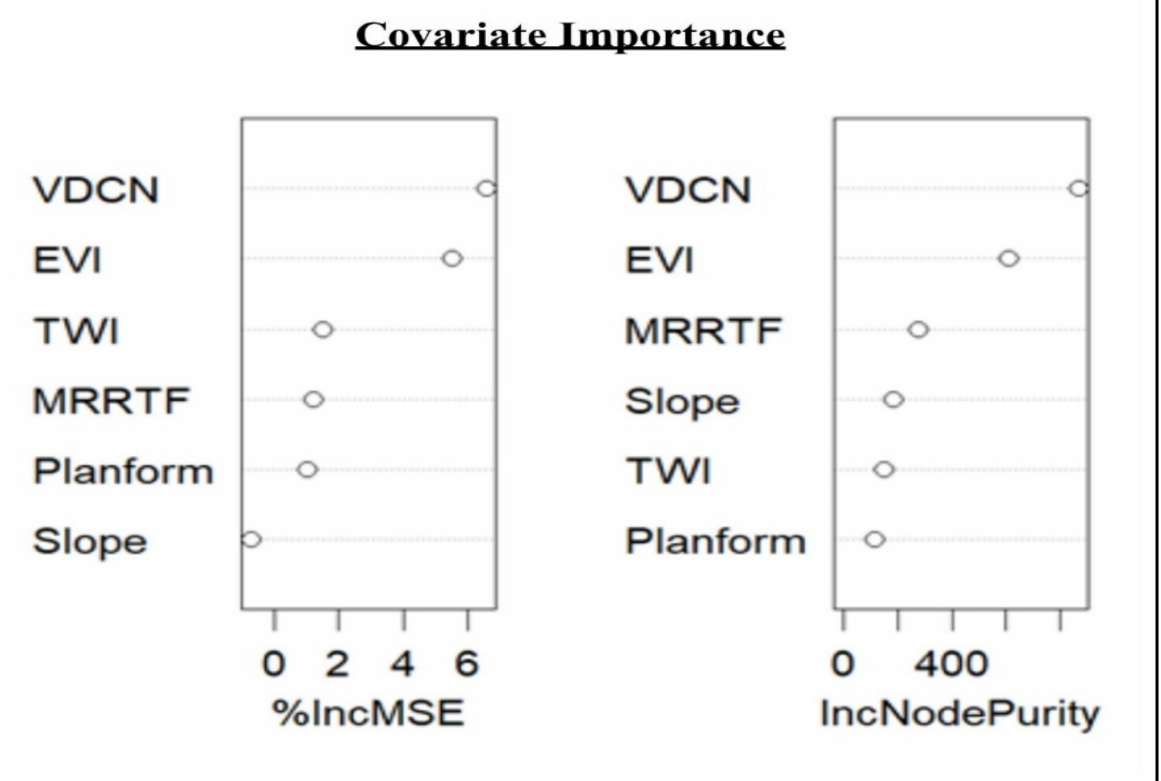
Figure 3. The relative covariate importance plot gained from the Random Forest (RF) model. The importance is assigned based on the percentage increase in MSE that would occur from removing each